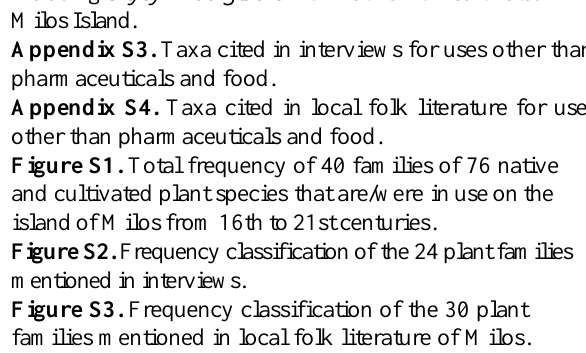
Figure S1. Total frequency of 40 families of 76 native and cultivated plant species that are/were in use on the island of Milos from 16th to 21st centuries. Figure S2. Frequency classification of the 24 plant families mentioned in interviews. Figure S3. Frequency classification of the 30